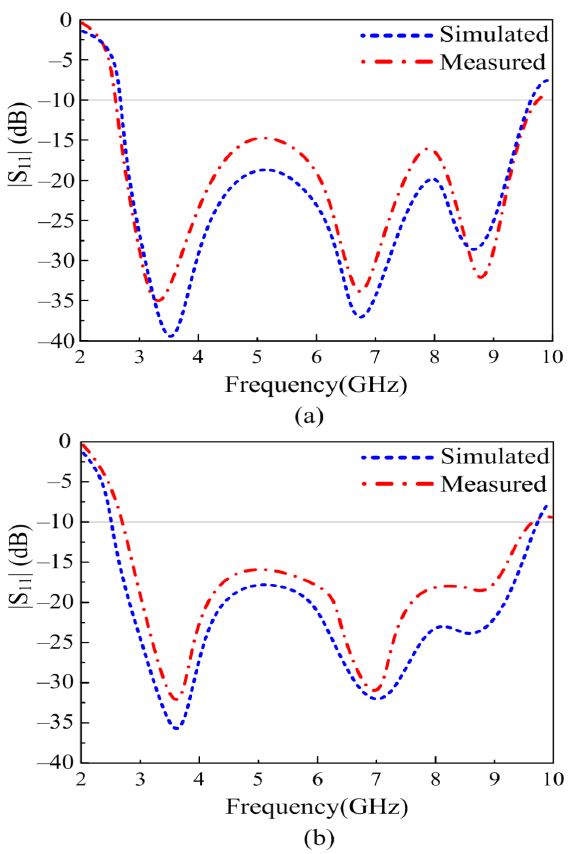
Figure 9. Comparison between predicted and measured reflection coefficients of the antenna under conformal conditions along the ( a ) X -axis and ( b ) Y -axis.